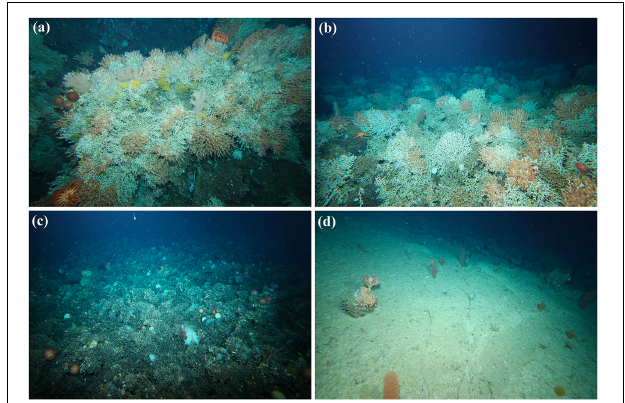
FIGURE 2 | Examples of reef formed by the stony coral Solenosmilia variabilis on Tasmanian seamounts showing: (a,b) high % cover and many live coral heads (living polyps are orange); (c) high % cover of dead matrix with no live coral heads; (d) low % cover and isolated single live